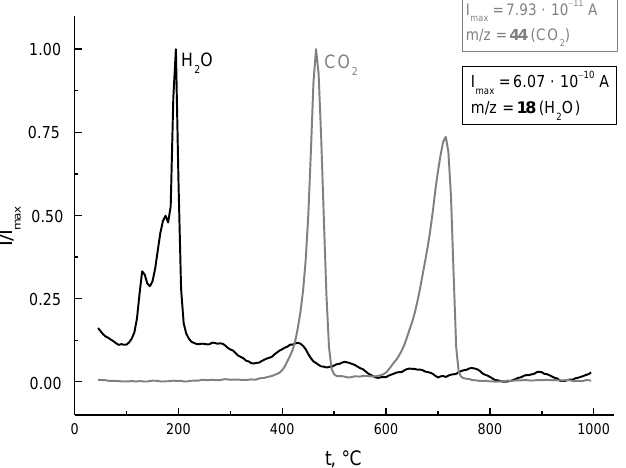
Figure 4. Mass spectra for evolving gases with m/Z=18 (in black) and m/Z=44 (in grey). Curves were normalized with respect to Imax = 6.07·10 − 10 A for H 2 O (m/Z = 18) and to Imax = 7.93·10 − 11 A for CO 2 (m/Z = 44).